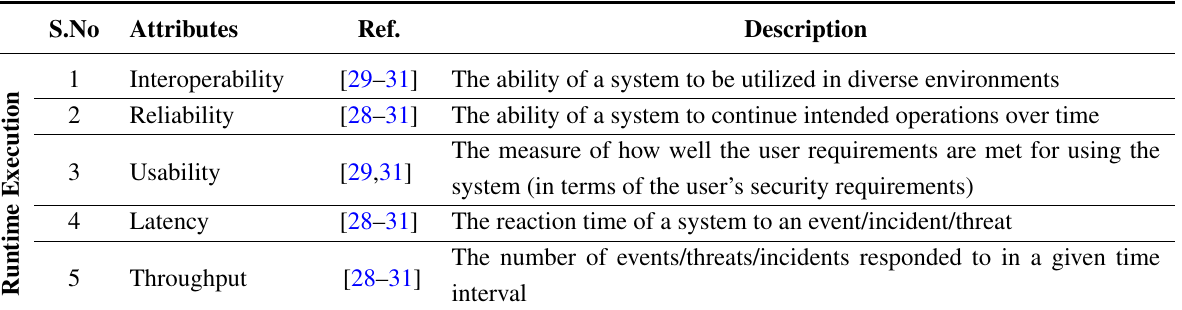
Table 3. System architecture quality